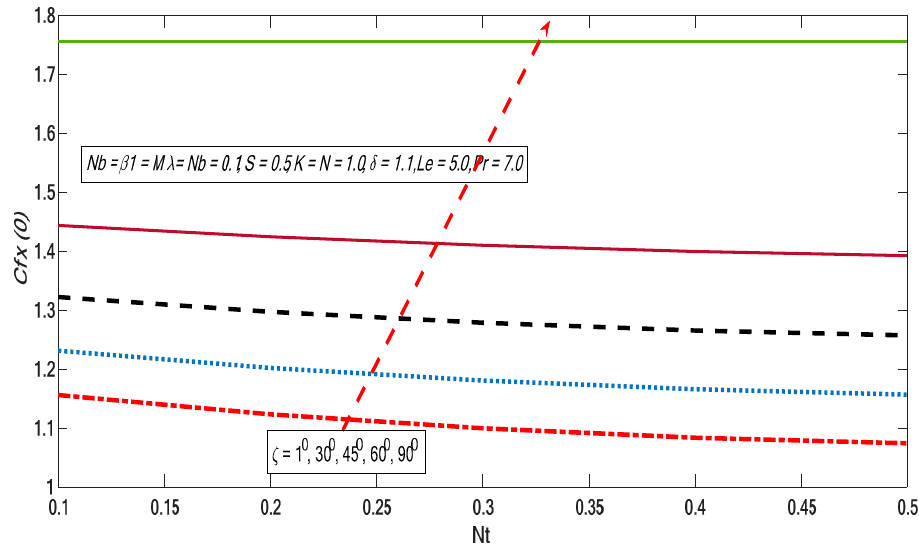
Figure 24. Variations of reduced Sherwood number with 𝑁𝑡 for different values of 𝜁 .